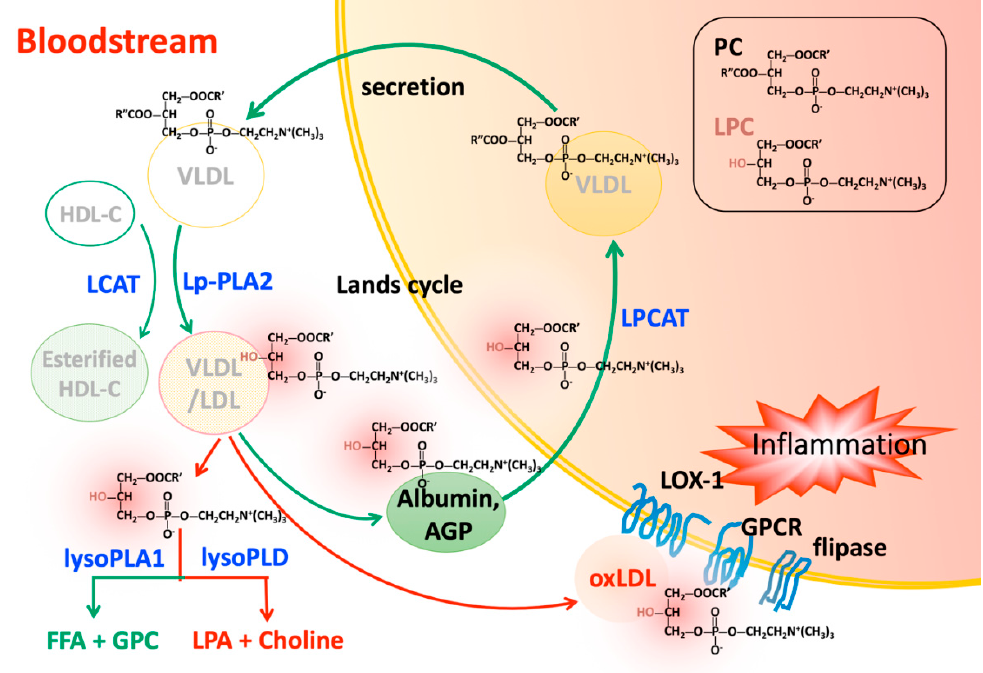
Figure 1. Phosphatidylcholines (PCs) are synthesized in the liver and secreted as components of very low density lipoprotein (VLDL). PCs are degraded via hydrolysis by Lp-PLA2 or conversion by LCAT. The metabolites, LPCs, can be transported back to the liver by albumin or AGP and then